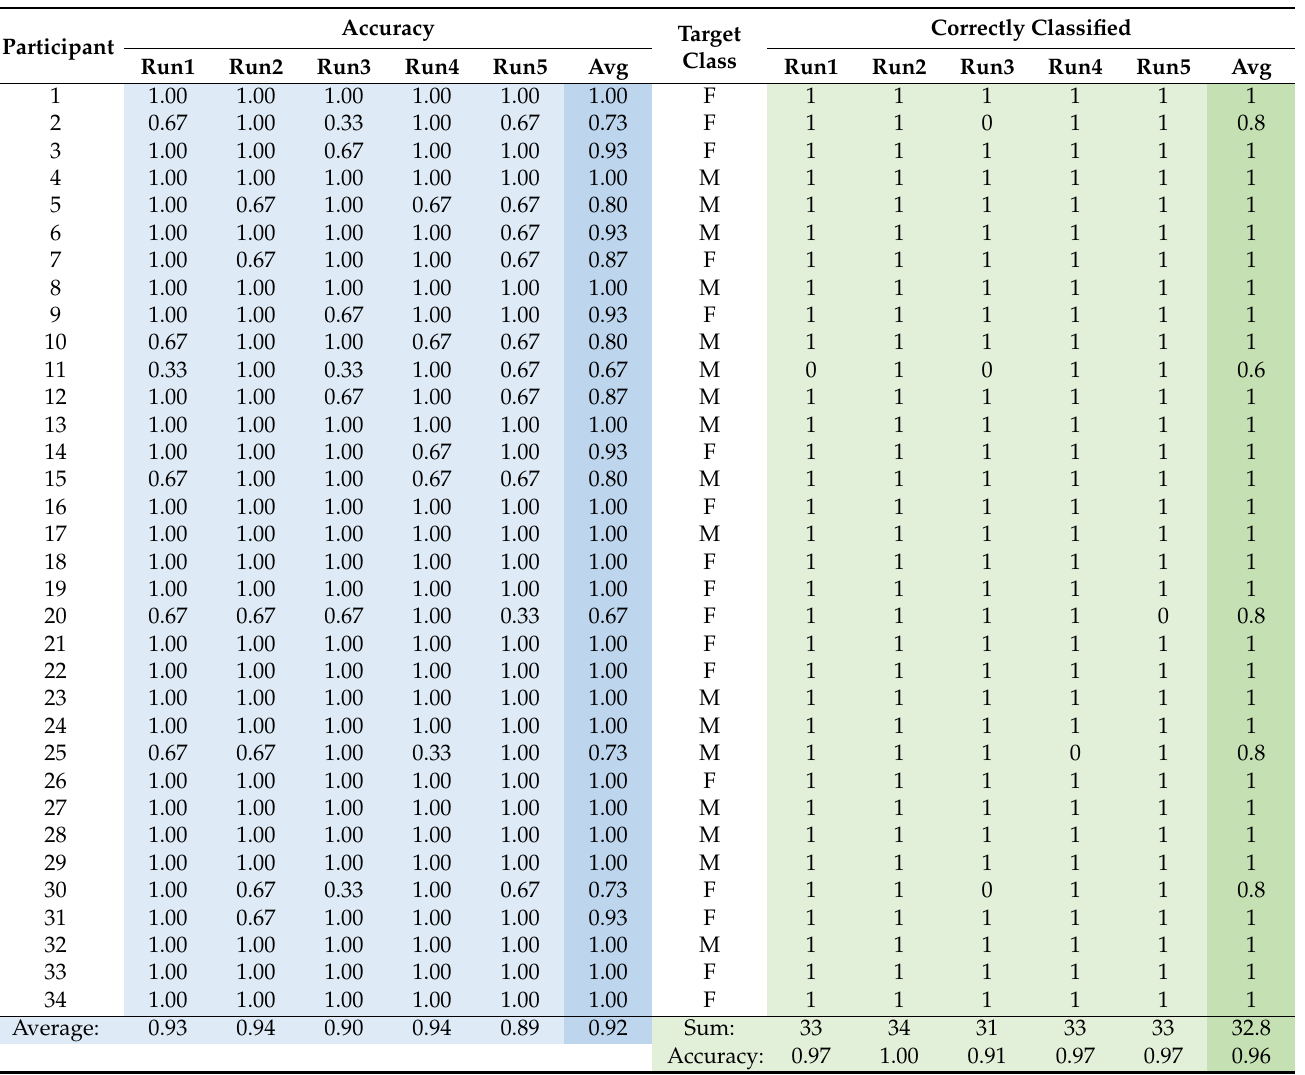
Table 6. Classification accuracies on the test data for drowsy